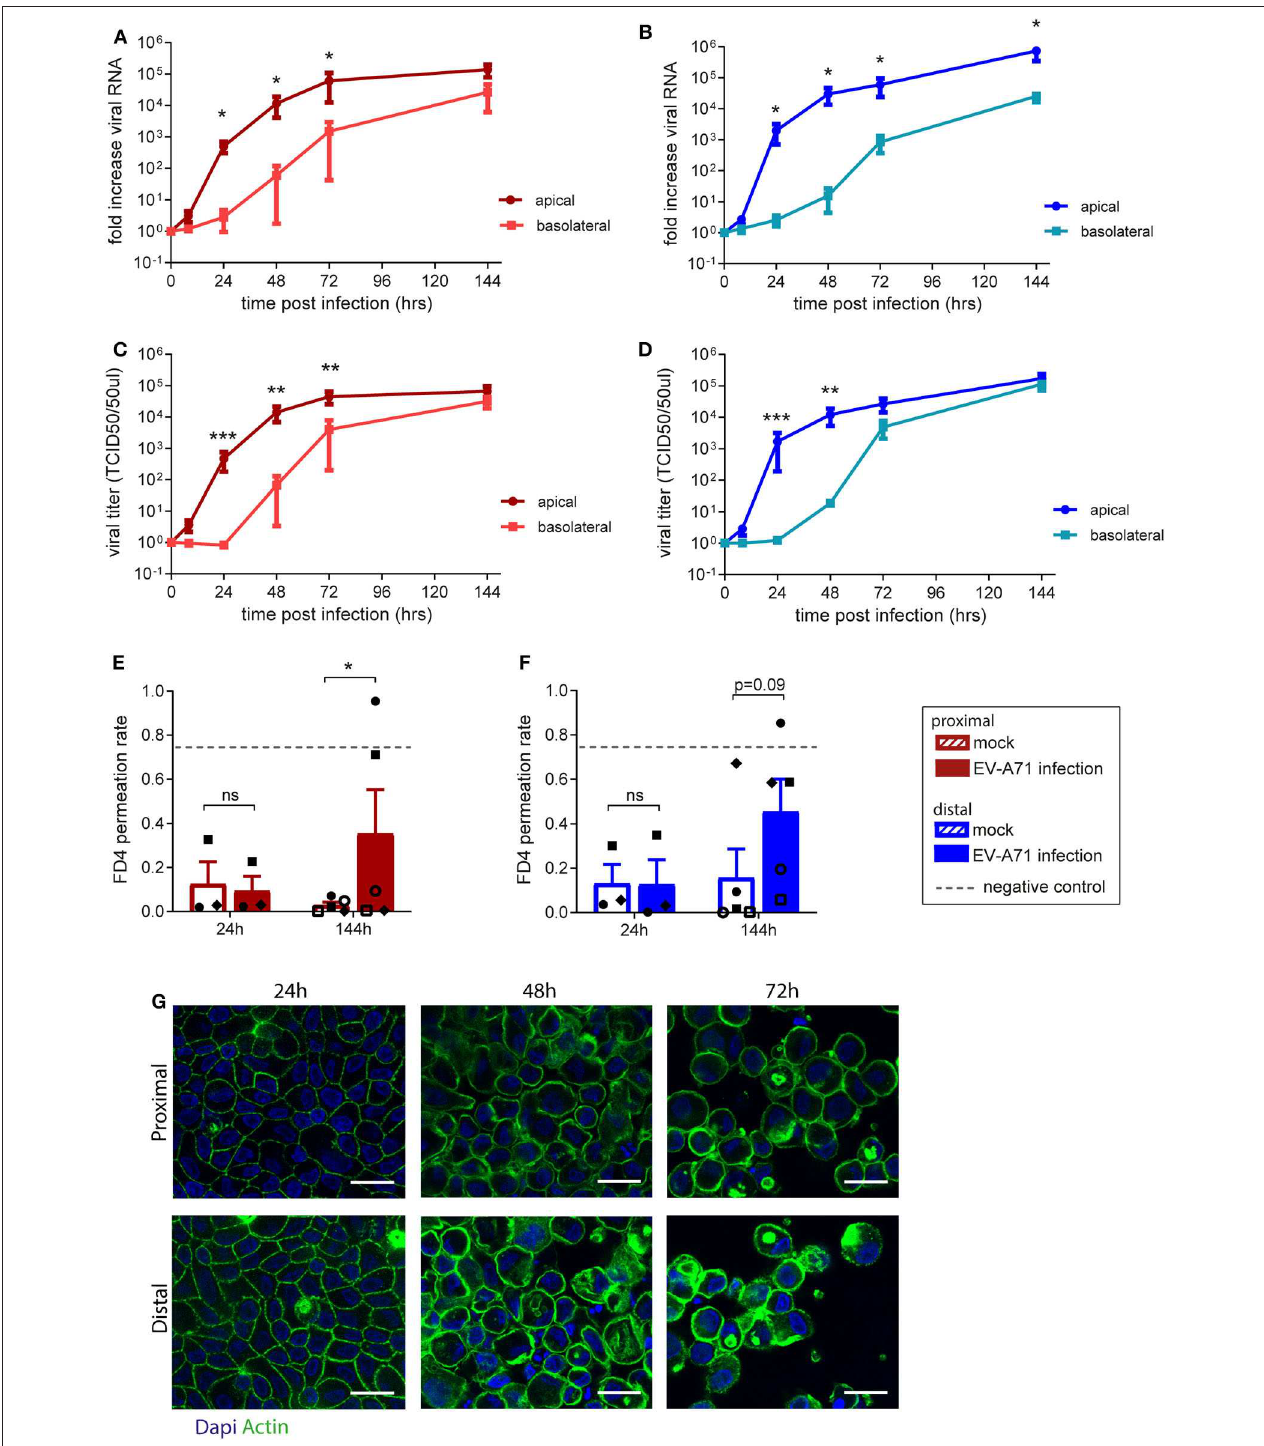
FIGURE 3 | Replication kinetics of EV-A71 in human small intestinal epithelial monolayer. (A,B) At 0 to 144h post infection, fold increase in viral RNA of EV-A71 in (A) proximal and (B) distal cultures was determined at regular intervals. (C,D) Fold increase in viral titers in (C) proximal and (D) distal cultures, at 0–144h post infection, with titers expressed as the 50% tissue culture infective dose (TCID50)/50 µ L. (E,F) Permeability was evaluated by permeation of FD4 from the apical to the basal compartment at 24 and 144h post infection in (E) proximal and (F) distal cultures, with empty transwells included as negative control (indicated by dotted lines). (G) Visualization of the monolayer integrity by IF staining for actin (green) on both proximal and distal cultures at 24, 48, and 72h post-infection. n = 5 for all except FD4 values at 24h post-infection, where n = 3. Values are mean ± SEM. * p < 0.05, ** p < 0.01, *** p < 0.001 as determined by paired t -test between apical and basolateral samples for viral replication (A–D) and between mock and EV-A71 infected transwell cultures (E,F) .